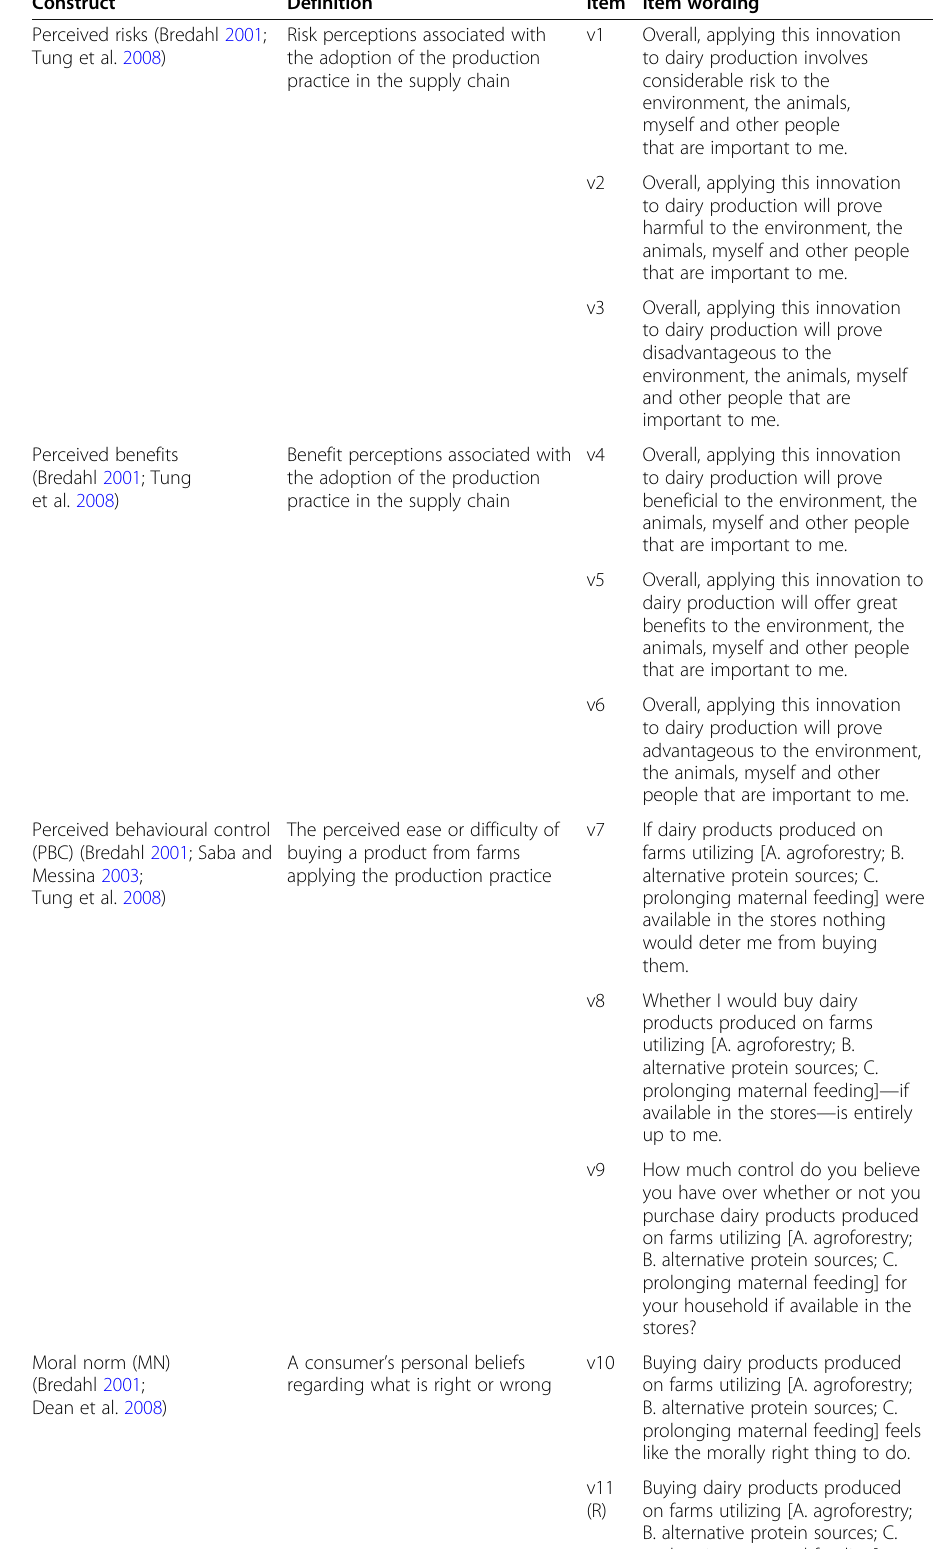
Table 1 Definition of the multi-item constructs (original